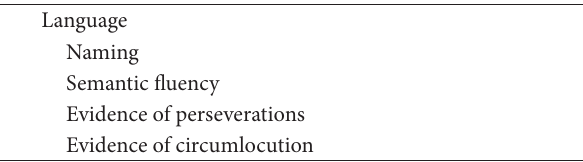
Table 1: Diagnostic assessment for